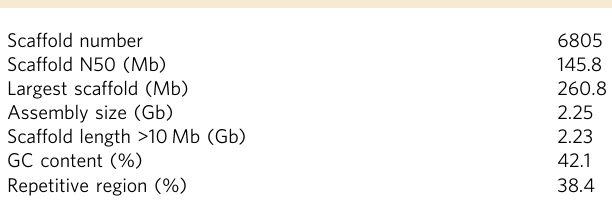
Table 1 Assembly statistics of the de novo black rat reference genome.